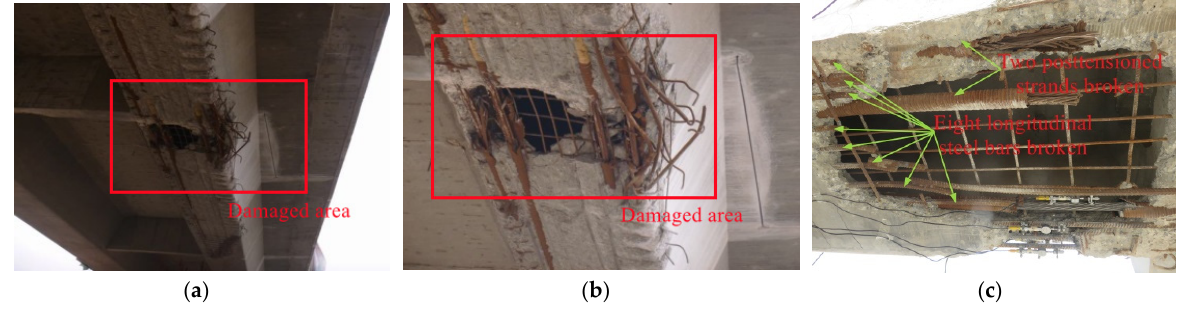
Figure 1. Details of the whole bridge layout (Unit: cm). ( a ) Elevation arrangement; ( b ) Plane layout; ( c ) Cross-sectional layout. slight abrasion in the local position.